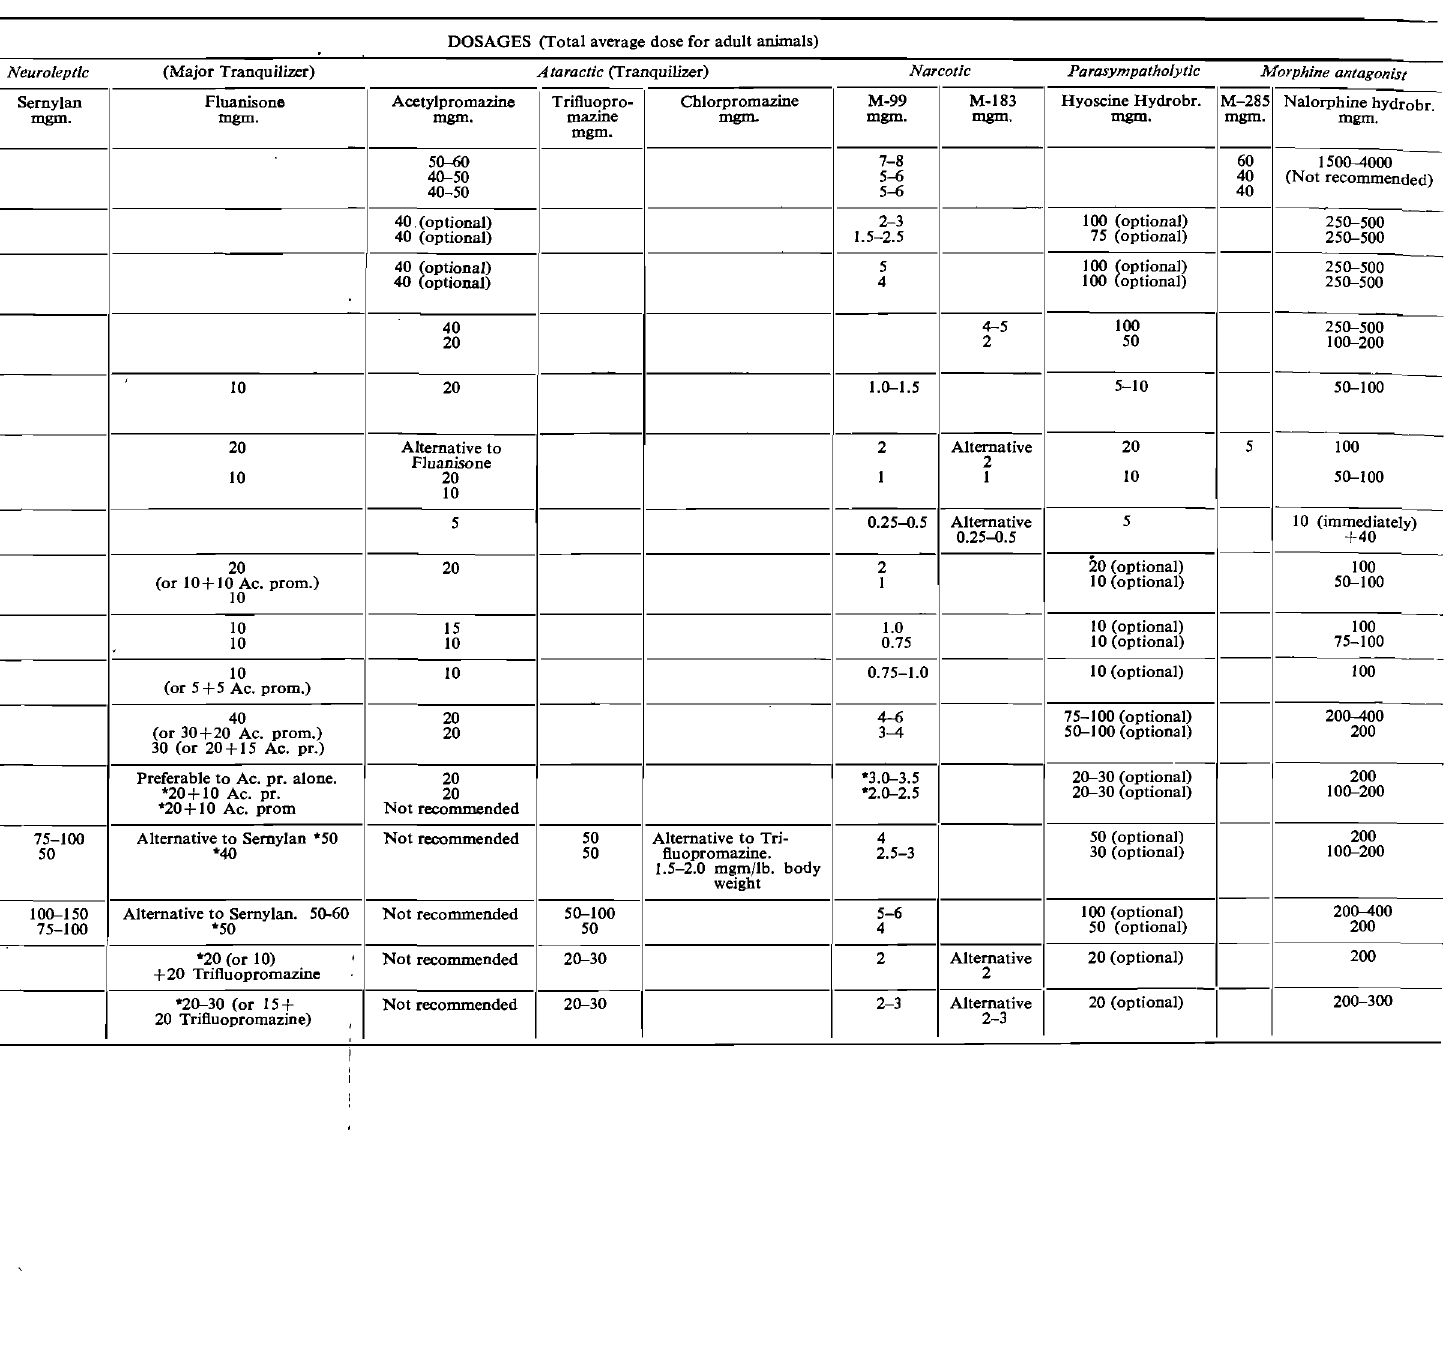
TABLE I.-DOSAGE RATES OF DRUGS USED FOR NEUROLEPTIC NARCOSIS IN 16 SPECIES OF HOOFED WILD ANIMAlS IN SOUTH AFRICAN NATIONAL